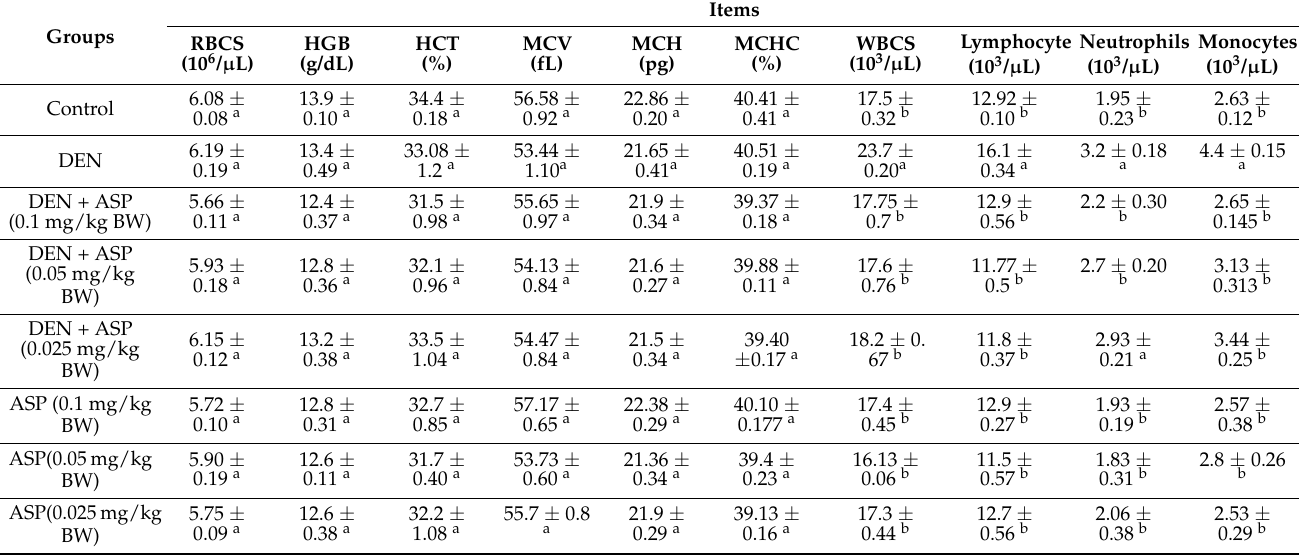
Table 4. Hematological findings of control, DEN and Aspergillus awameri supplemented rat